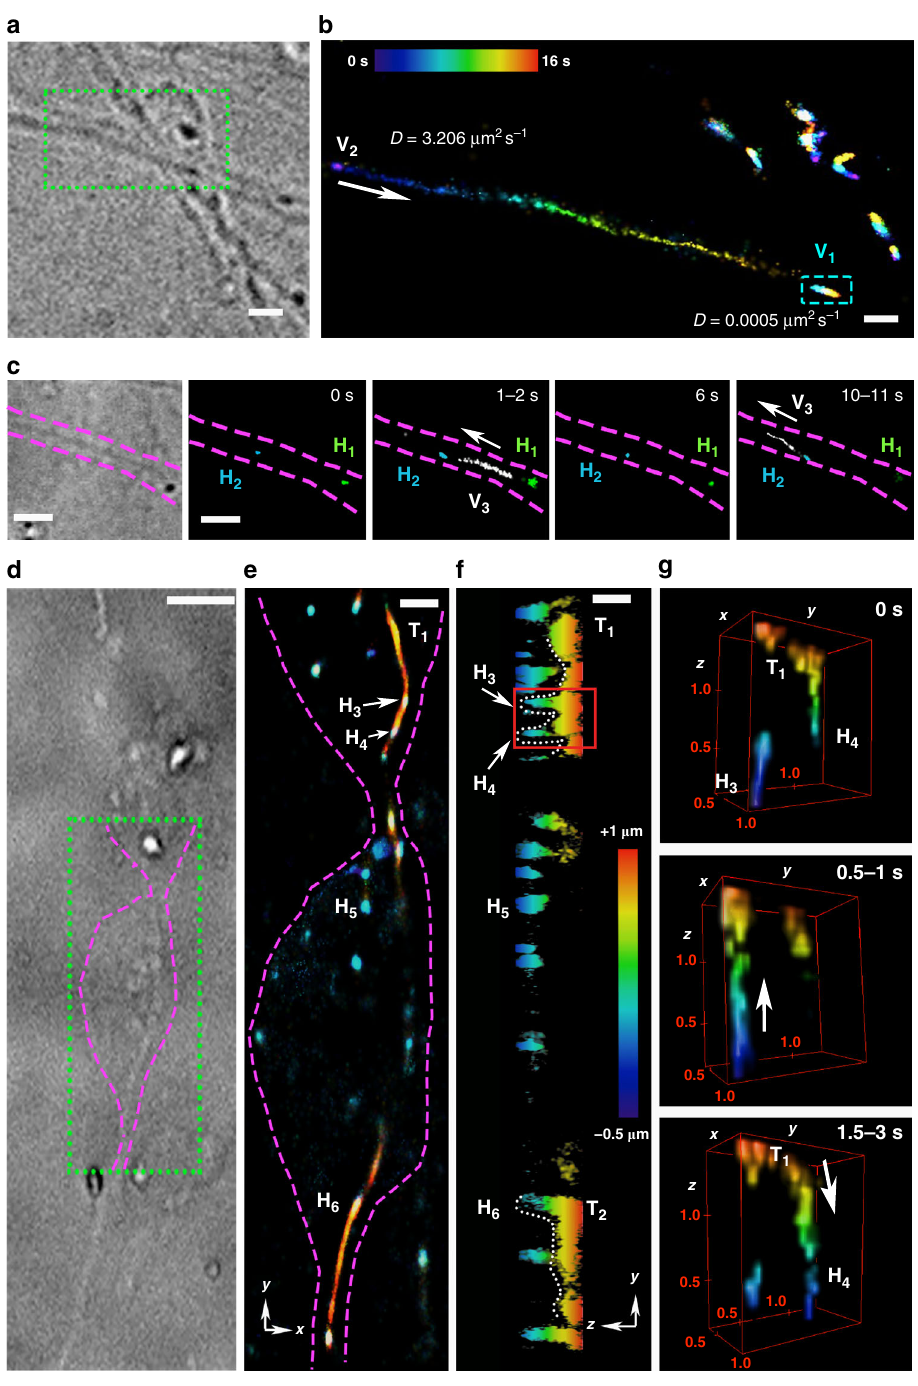
Fig. 5 Single-vesicle tracking in human neurons. a Bright- fi eld image of a neuronal projection and synapse. The green, dotted box indicates the area depicted in panel ( b ). b Image reconstructed from all frames collected during a 16 s acquisition and color-coded according to time. Diffusion coef fi cients were determined for two vesicles (V 1 and V 2 ). The cyan, dotted rectangle indicates the area in which V 1 moves. Other unlabeled vesicles are also present in the top-right area of the image. ( c ) Bright- fi eld image of a single neuronal projection and fast diffusion of an acidic vesicle (V 3 ) between hotspots (H 1 and H 2 ) in 20 s. The arrows indicate the direction of travel of the fast-moving vesicle. d Bright- fi eld image of two neuronal projections meeting at a synapse. The green, dotted box indicates the area depicted in panel ( e ). e 3D SMLM depiction merging all frames acquired over 40 s, giving a long-term image in which tracks of fast vesicle movement emerge and color-coded according to depth (see color bar in panel ( f )). f Image of panel ( e ) projected across the axial plane ( y – z ), color-coded according to depth. A region of interest (ROI) containing track T 1 and hotspots H 3 and H 4 was selected (red, solid- line square) to display as a time series and 4D volume in panel ( g ). g 3D images at selected time points displaying a vesicle moving from hotspot H 3 to H 4 through track T 1 . The volumes were colored according to the bar in panel ( f ). The unit cell is 1.5 μ m × 1.5 μ m × 1.5 μ m and labeled with ticks of 0.5 μ m. Scale bars from panels ( a , b ) 2 μ m; ( c , e ) 1 μ m, ( d ) 5 μ m; ( f ) 750